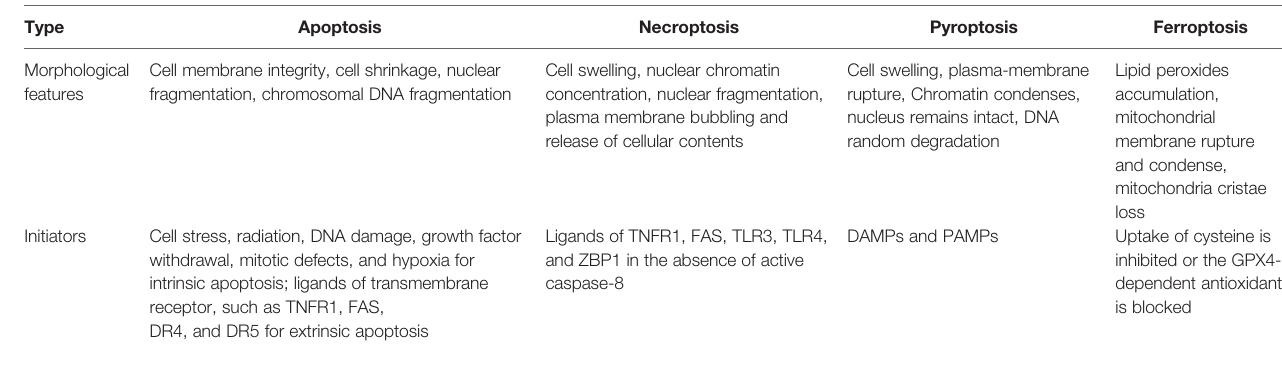
TABLE 1 | Comparison of the main features of different cell death. Type Apoptosis Morphological features